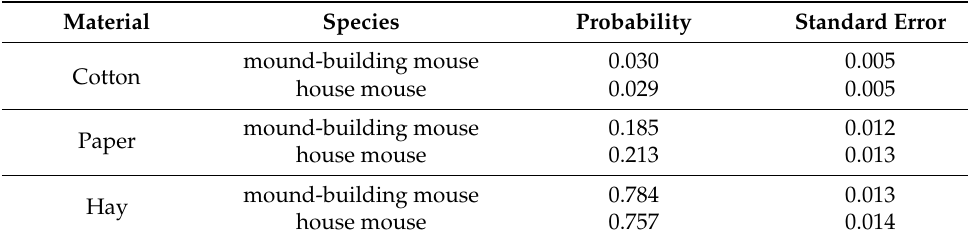
Table 1. The predicted probability of nest selection estimated by species.